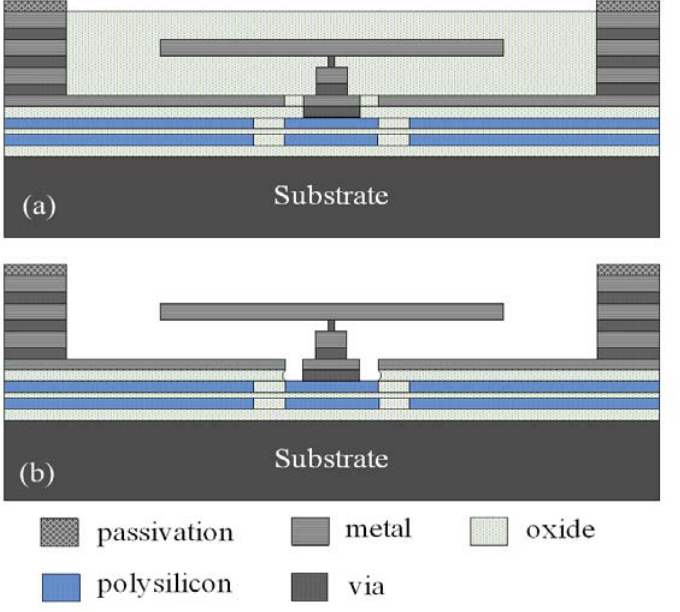
Figure 5. Process flow of the micromirror: (a) after completion of the CMOS process; (b) after completion of the